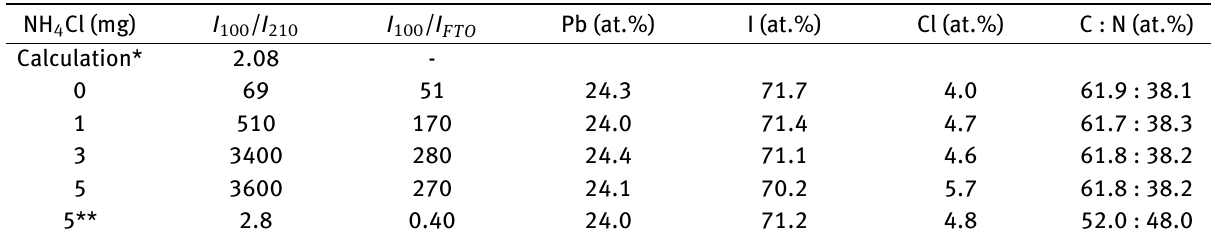
Table 14: Ratios of 100 diffraction intensities ( I 100 ) to 210 diffraction intensities ( I 210 ) and FTO substrate diffraction intensities ( I FTO ), for the perovskite crystals. Compositions of the solar cells as measured by EDS.